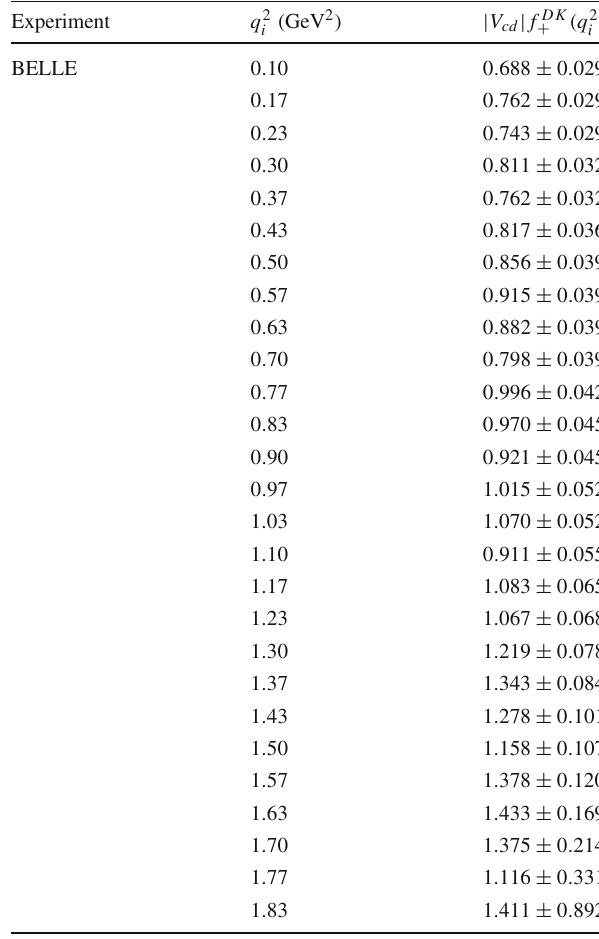
Table 8 Values of | V cs | f DK + ( q 2 collected in Ref.